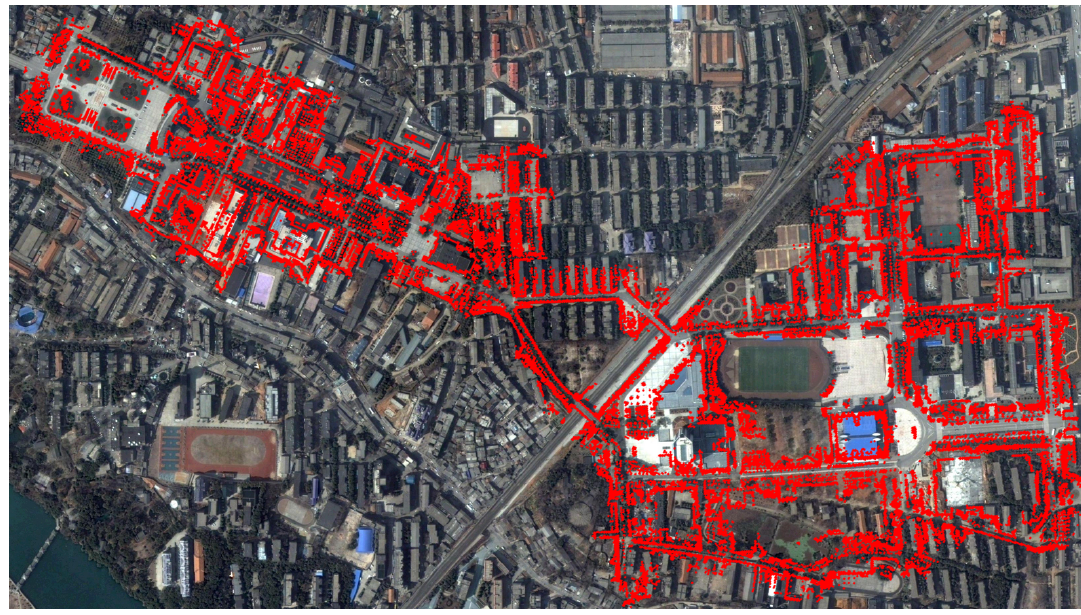
Figure 11. Mapping of the campus #1